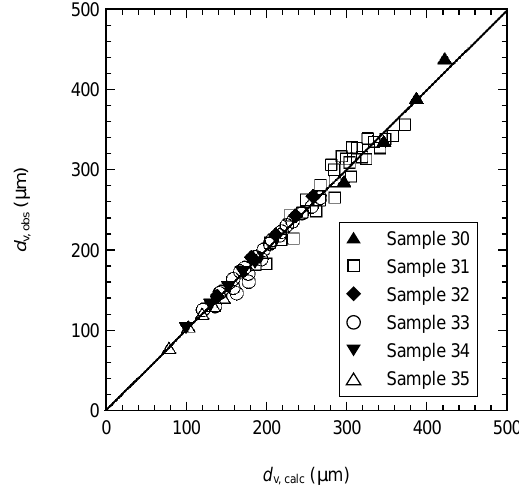
Dimensionless Correlation of Mean Volume Diameter of Silica Particles Produced under the Conditions of This